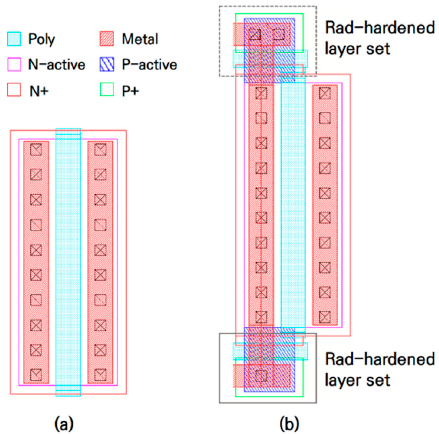
Figure 13. n-MOSFET layout drawings in the 0.18-um CMOS process ( a ) standard and ( b ) RH V-gate n-MOSFET.